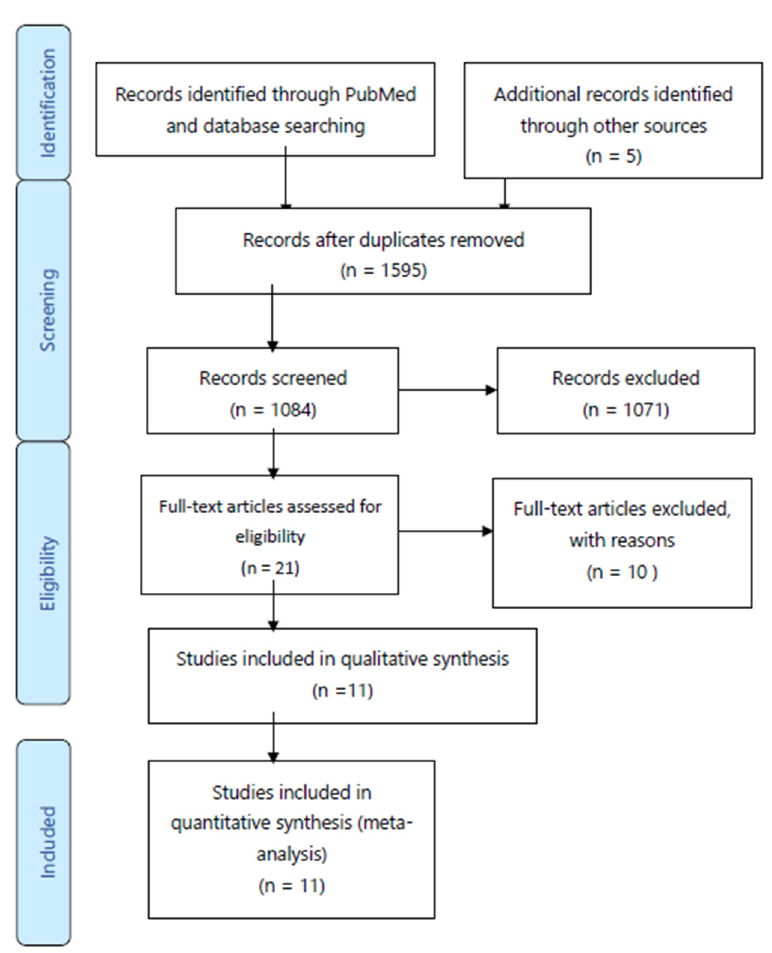
Figure 1. PRISMA flow diagram of selected studies.